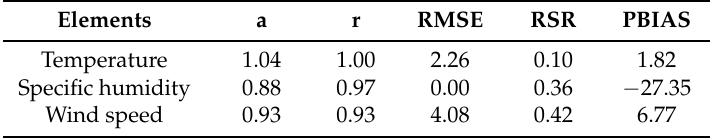
Table 4. Simulated evaluation of temperature, specific humidity and wind